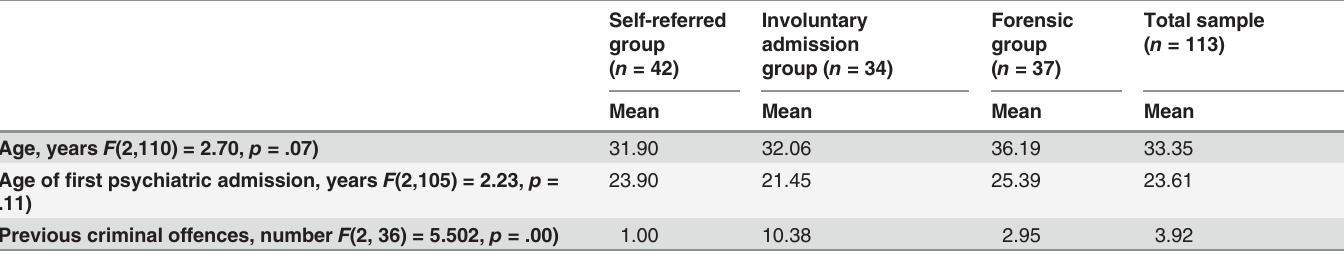
Table 1. General characteristics of the self-referred, involuntary admission, and forensic